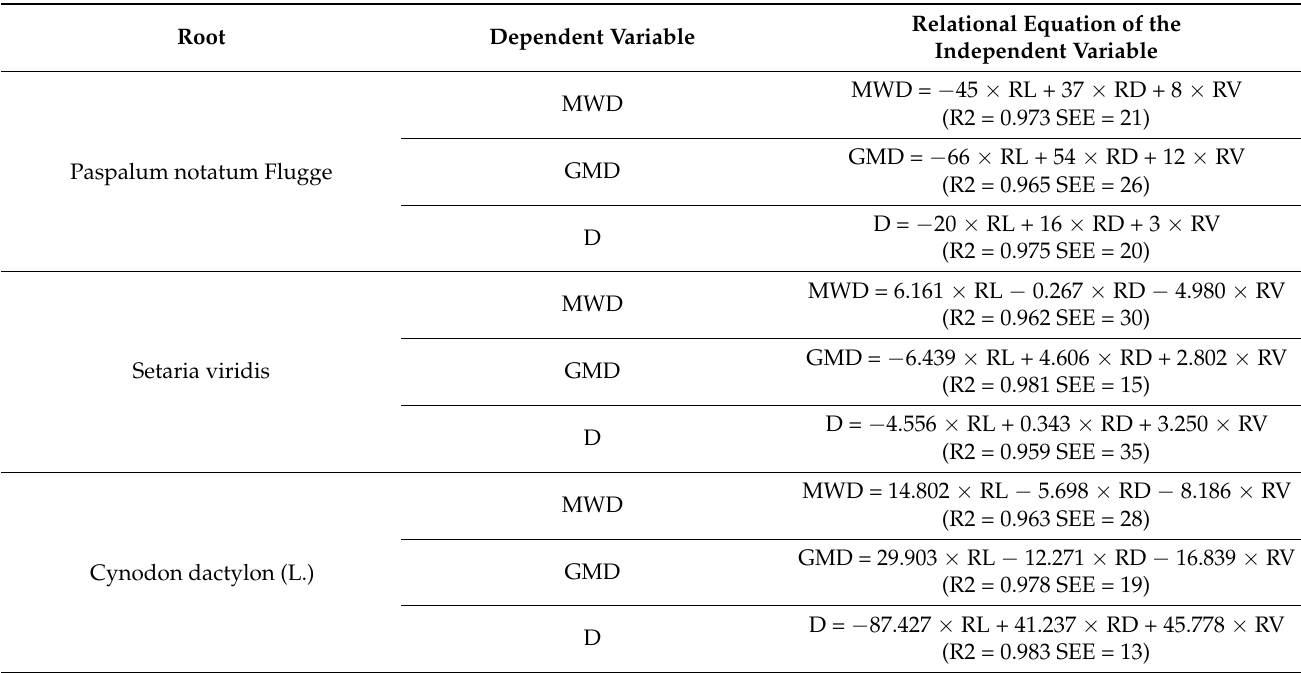
Table 7. Correlation equation for the variable tailings containing the Paspalum notatum Flugge root